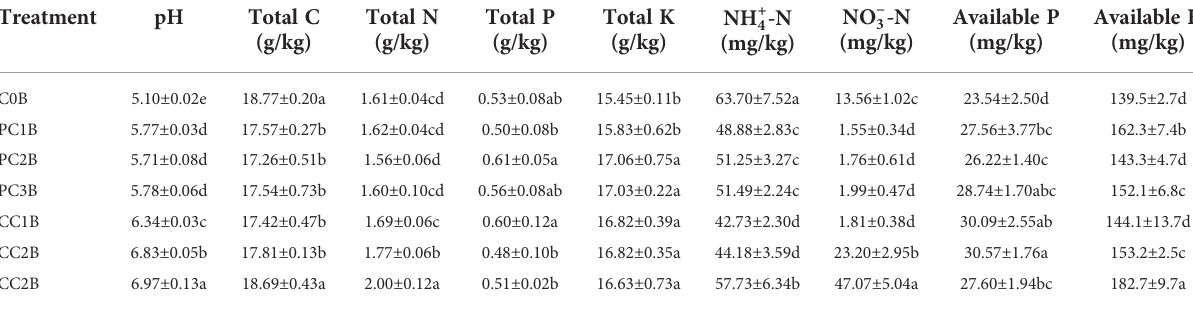
TABLE 1 Soil chemical properties under different pure and crude chitin addition dosages in the bulk soils.